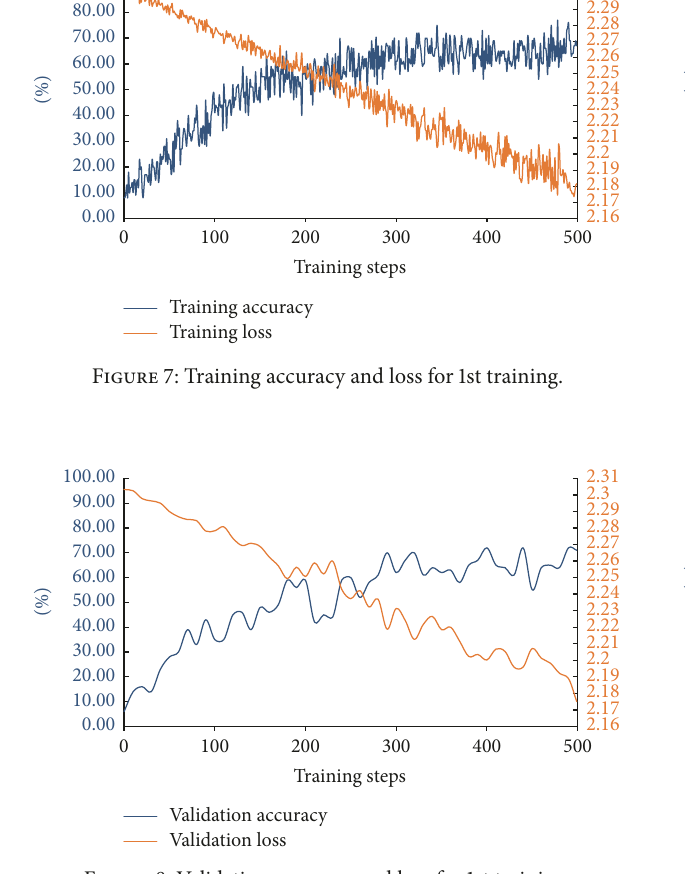
directory. The predictions are compared with the actual labeled image. The evaluation process will update the final layer’s weights through a backpropagation process.